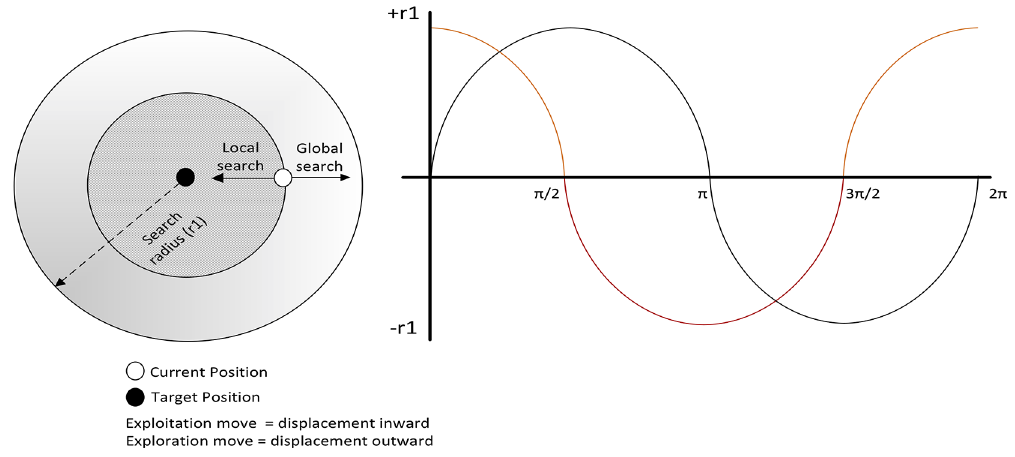
Fig 3. Effects of Sine and Cosine on search